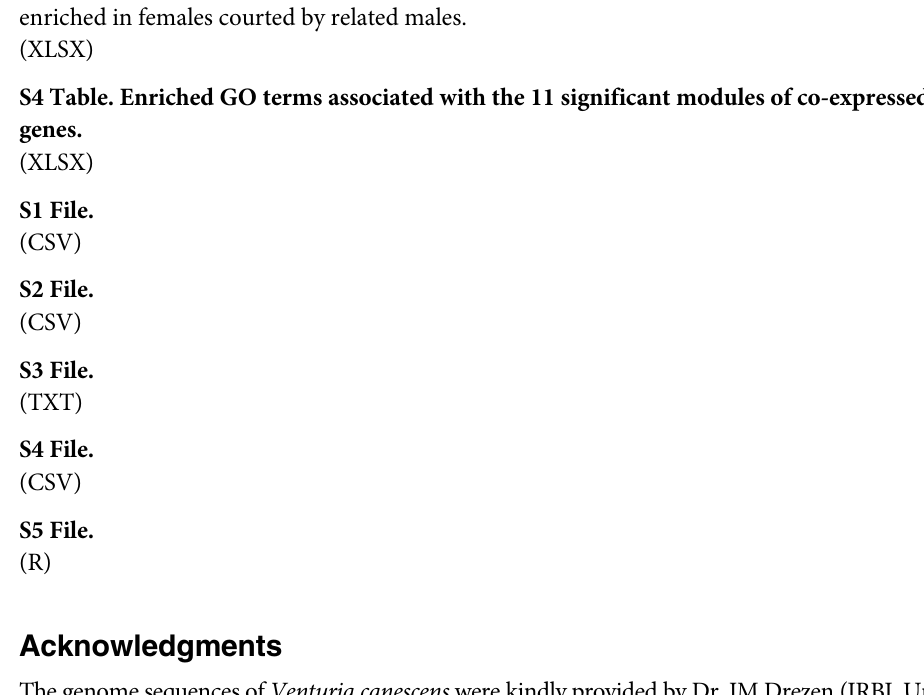
S2 Fig. Boxplot showing expression patterns of the 6 members of the yellow–mrjp family were regulated following courting displays and/or according the relatedness between the female and the courting male. Boxplot colours indicate biological condition: grey, isolated females; blue, females courted by unrelated males; orange, females courted by related males. The Y axes show the normalized counts after log transformation and VST normalization, and the boxplot whiskers show the range of reads between biological replicates. � , P -adj (FDR) < 0.01; NS, not significant. S3 Fig. Boxplots showing the expression patterns of the top 5 hub genes for each of the 11 modules varied according to experimental conditions. The Y axes show the normalized counts after log transformation and VST normalization, and the boxplot whiskers show the range of reads between biological replicates. S1 Table. Summary statistics of the sequencing runs and transcriptome assembly. S2 Table. Control females versus females courted by both related and unrelated males: A) list of 1,001 DEGs; B) 7 GO terms enriched in control females; C) 36 GO terms enriched in courted females. S3 Table. Females courted by related males versus females courted by unrelated males: A) list of 831 DEGs; B) 22 GO terms enriched in females courted by unrelated males; C) 66 GO terms enriched in females courted by related males. S4 Table. Enriched GO terms associated with the 11 significant modules of co-expressed